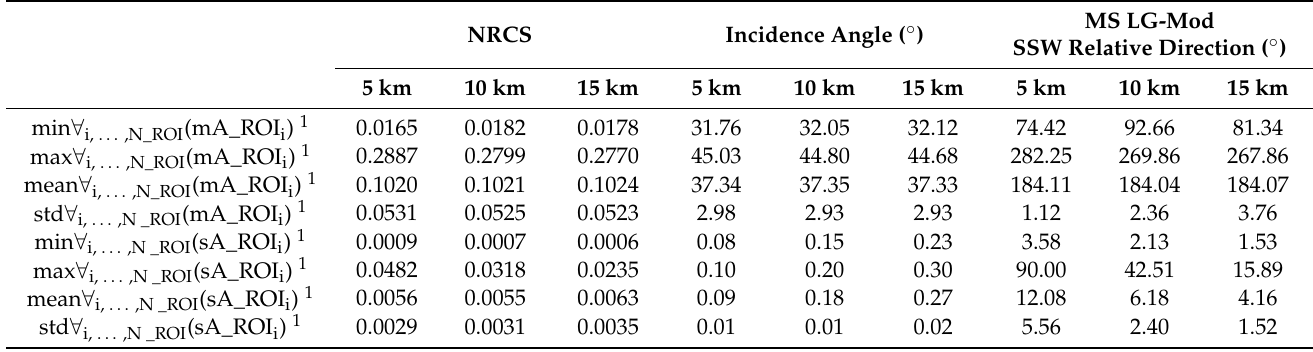
Table 1. Statistics about the mean and standard deviation values of the input parameters SAR Normalised Radar Cross Section (NRCS), incidence angle and MS LG-Mod SSW relative direction for all Wind Vector Cells (WVCs or ROIs), at various